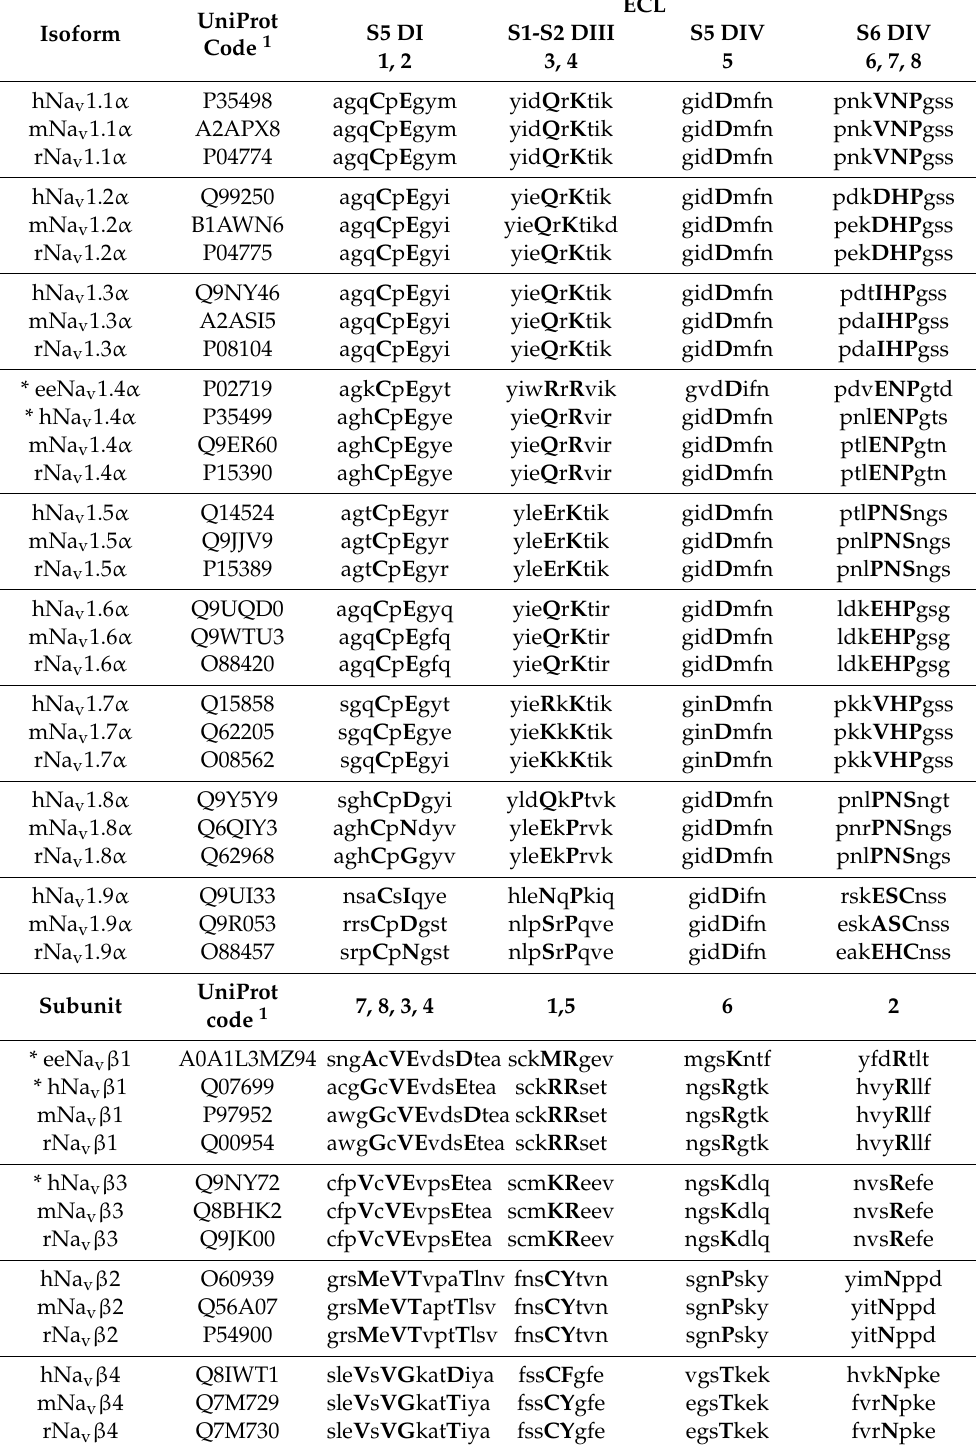
Table 2. Multiple sequence alignments for either all nine α subunits or all four β subunits of three Mammalian organisms in addition to eel 3D template. MSA identified eight conserved or homologous residues on Na v α and Na v β . Asterisks (*) in first column: 3D template structures from PDB. Capital letters in bold face: the eight residues. Lower case letters: amino acid neighbors of the eight residues for numberless identification. Colors: positively and negatively charged residues in blue and red, respectively; polar or non-polar residues in cyan or